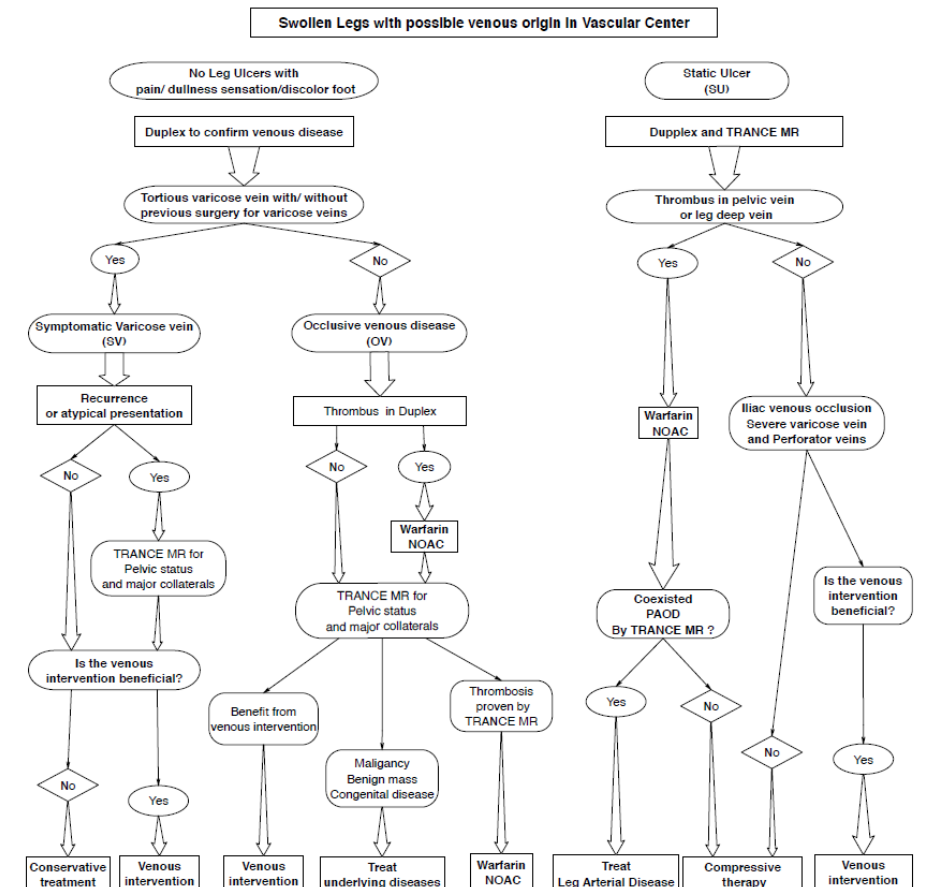
Figure 4. Therapeutic algorithm in the vascular centre—application of TRANCE-MRI for the lower extremity with venous origin. NOAC: non-warfarin oral anticoagulation.